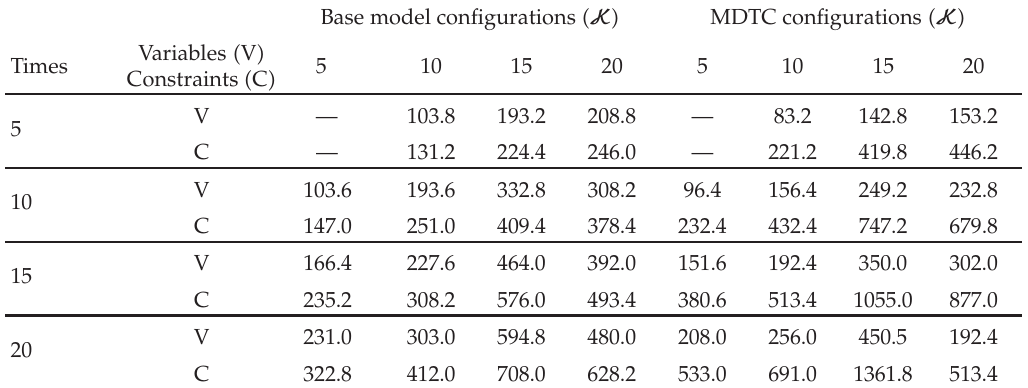
Table 3: Average (cid:2) utilizing 30 trials per parameterization (cid:3) problem sizes under various parameters. Base model configurations (cid:2) K